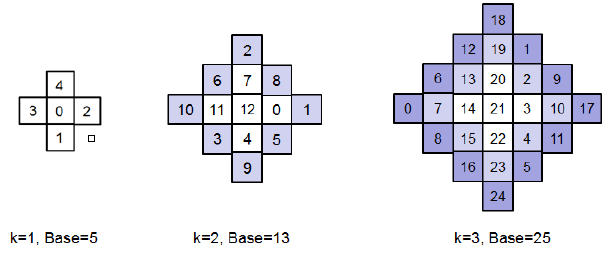
Figure 1. Diamond search block with k =1, k =2, k =3